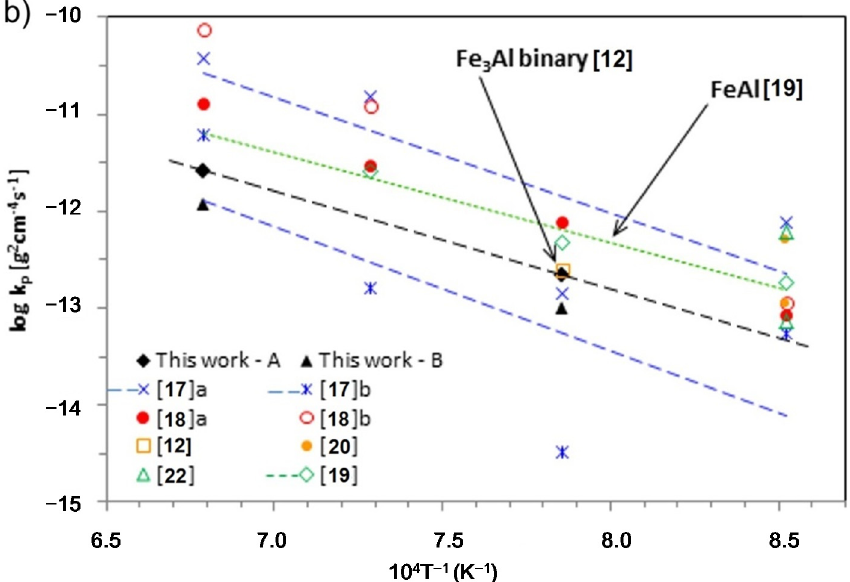
Figure 4. Time dependence of the square of mass grain per unit surface area vs. oxidation time for thin-walled prepared by LENS after processing and grinding ( a ) and Arrhenius plot for the parabolic rate constants of Fe 3 Al and FeAl ( b ). Own data are plotted in black, colors shows literature data from Table 1.